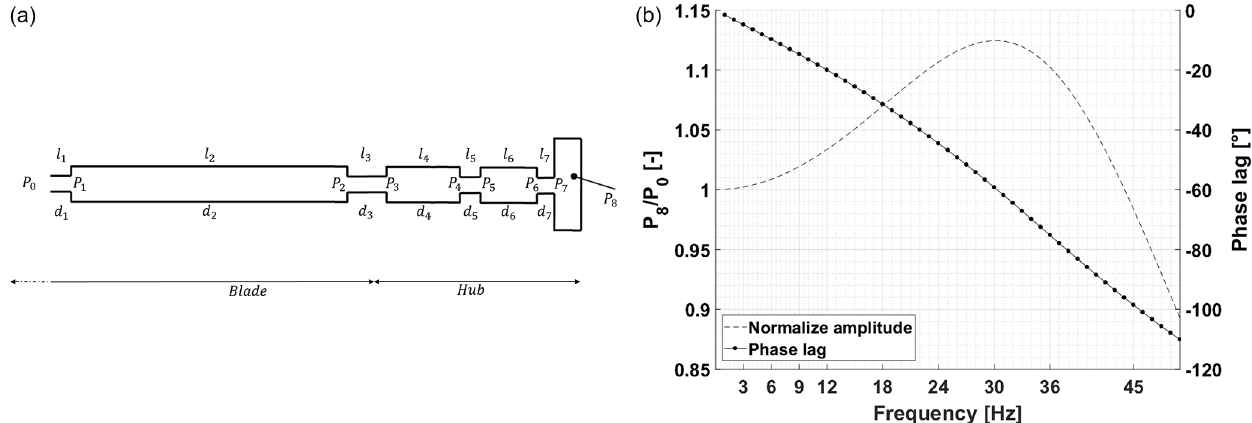
Figure 8. Scheme of the model to apply Bergh and Tijdeman (1965) dynamic response analysis. P , l and d are the pressure, length and diameter of each section (a) . Theoretical dynamic response of the amplitude and phase lag (b)